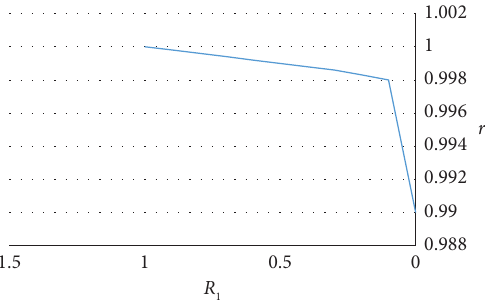
Figure 6: Te confdence chart of 􏽥 U